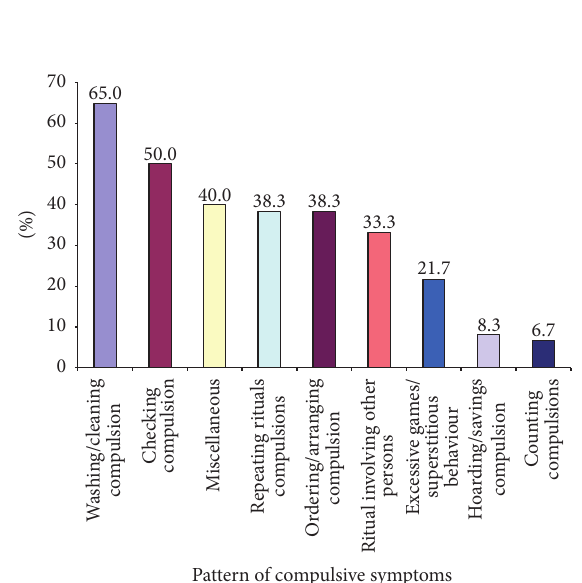
Figure 2: Pattern of compulsive symptoms among 8–18-year-old respondents ( 𝑛 = 60